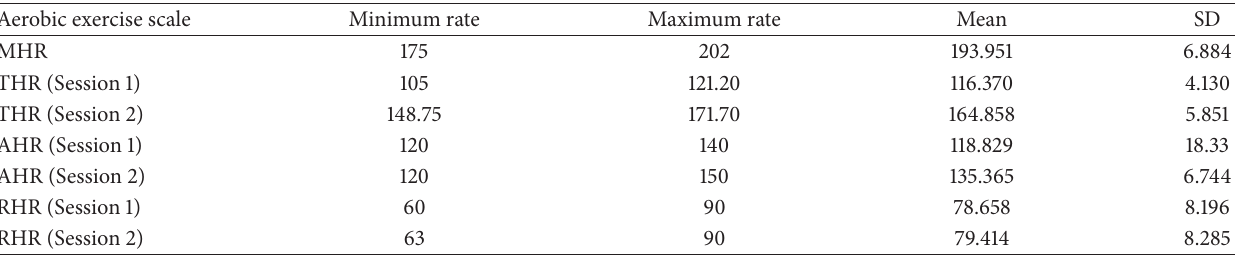
Table 1: Heart rates of aerobic exercise.